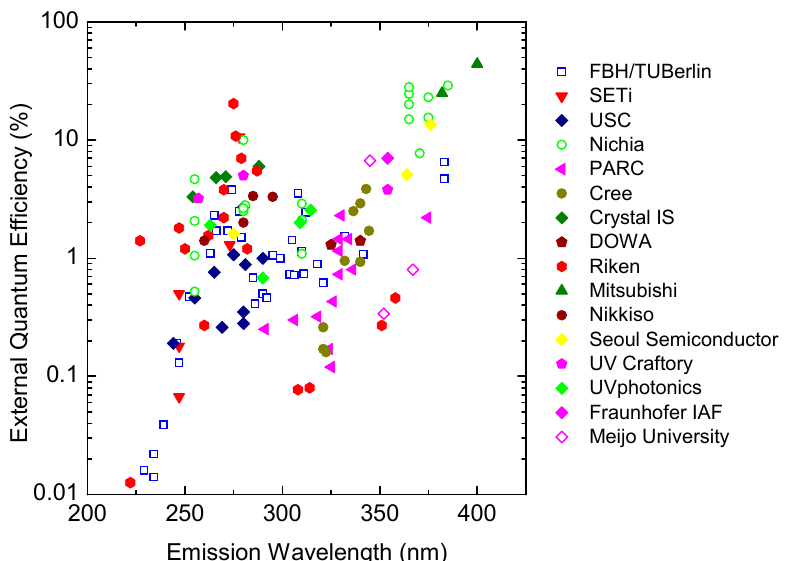
Figure 1. Reported external quantum efficiencies (EQE) for group III-nitrides-based near and deep ultraviolet (DUV) light-emitting diodes (LEDs) [1–18]. In part courtesy of Prof. M. Kneissl of Technische Universität Berlin.